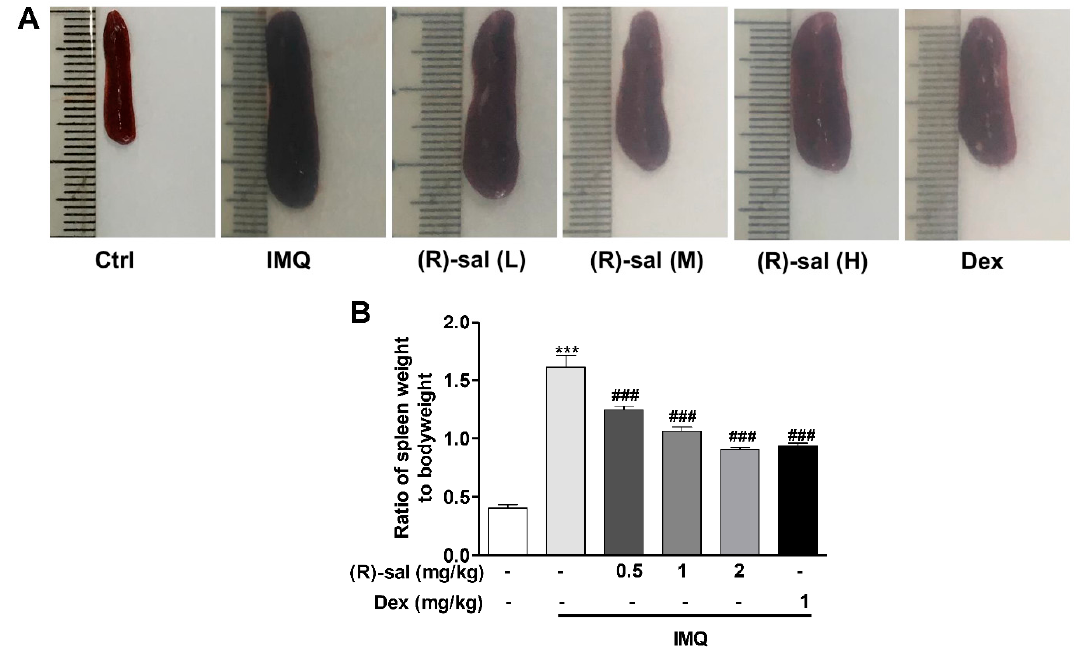
Figure 5. Effect of ( R )-salbutamol treatment on the ratio of spleen weight to bodyweight. ( A ) Representative photographs of spleen in different groups. ( B ) 24 h after the final administration, mice were sacrificed and the ratio of spleen weight to bodyweight was determined. ### p < 0.01, compared with IMQ group. *** p < 0.001, compared with control group. Each bar represents the mean ± SD ( n = 8).